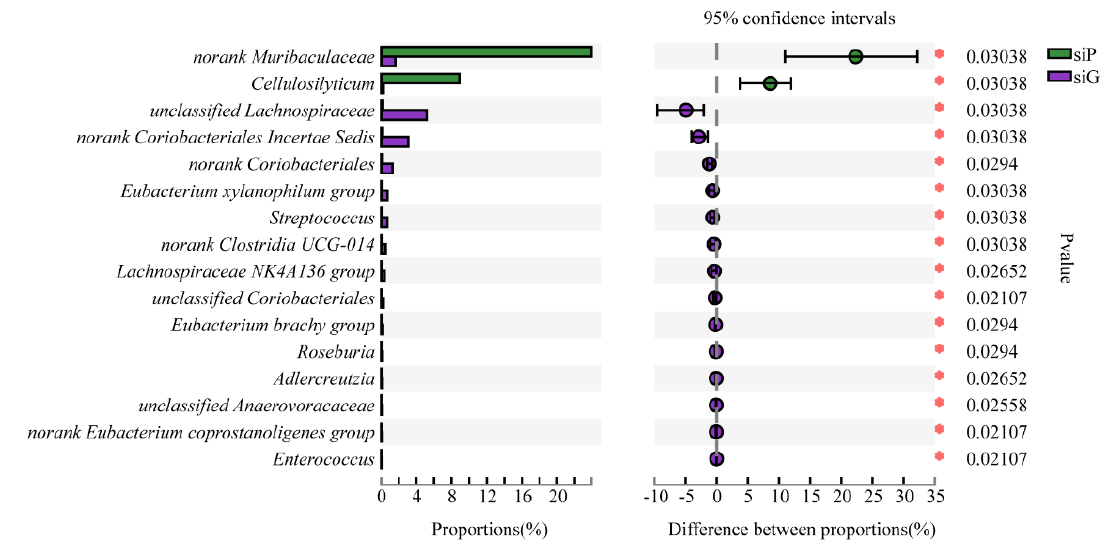
Figure A3. Wilcoxon rank–sum test bar plot at the genus level for the comparison of the microbiota in the small intestine. The relative abundances of 16 genera were tested and found to be significantly different between the siP and siG groups. * 0.01 < p <